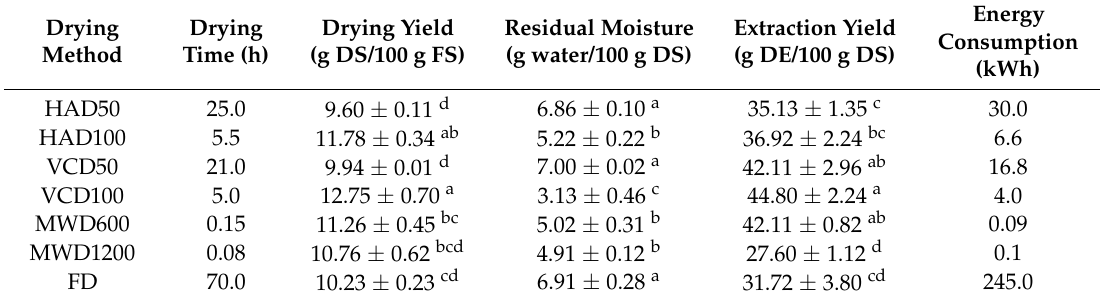
Table 1. Physicochemical properties of carrot peel dried at various conditions ( n =